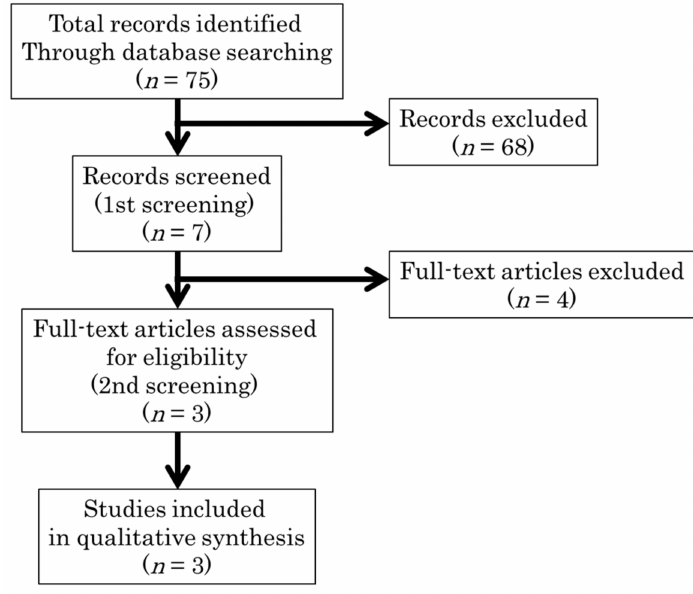
Figure 2. Flow diagram of selecting the carbohydrate studies included in our study. Three randomized controlled trials were appraised in our systematic